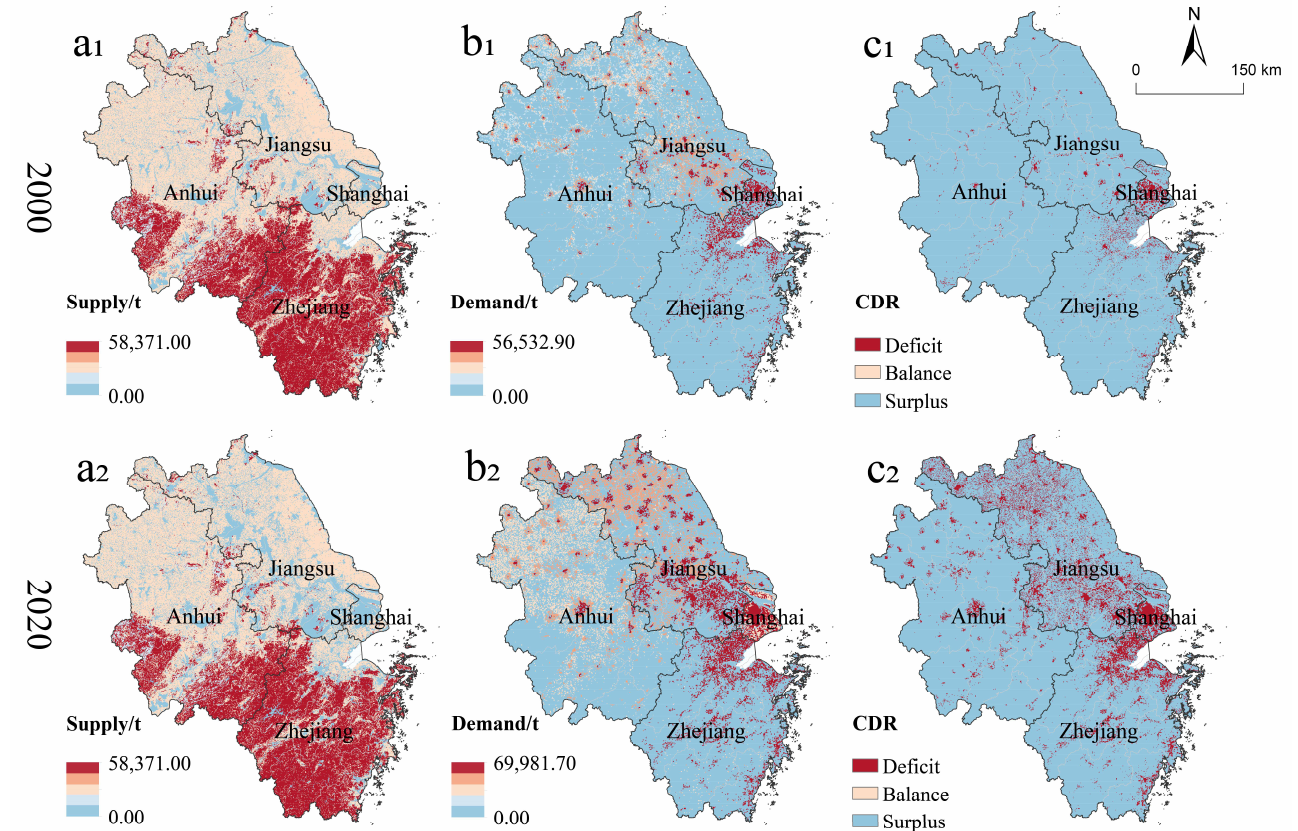
Figure 5. Spatial distribution of carbon storage supply ( a 1 , a 2 ), carbon storage demand ( b 1 , b 2 ) and CSDR ( c 1 , c 2 ) in YRD in 2000 ( upper panel) and 2020 ( lower panel), respectively.